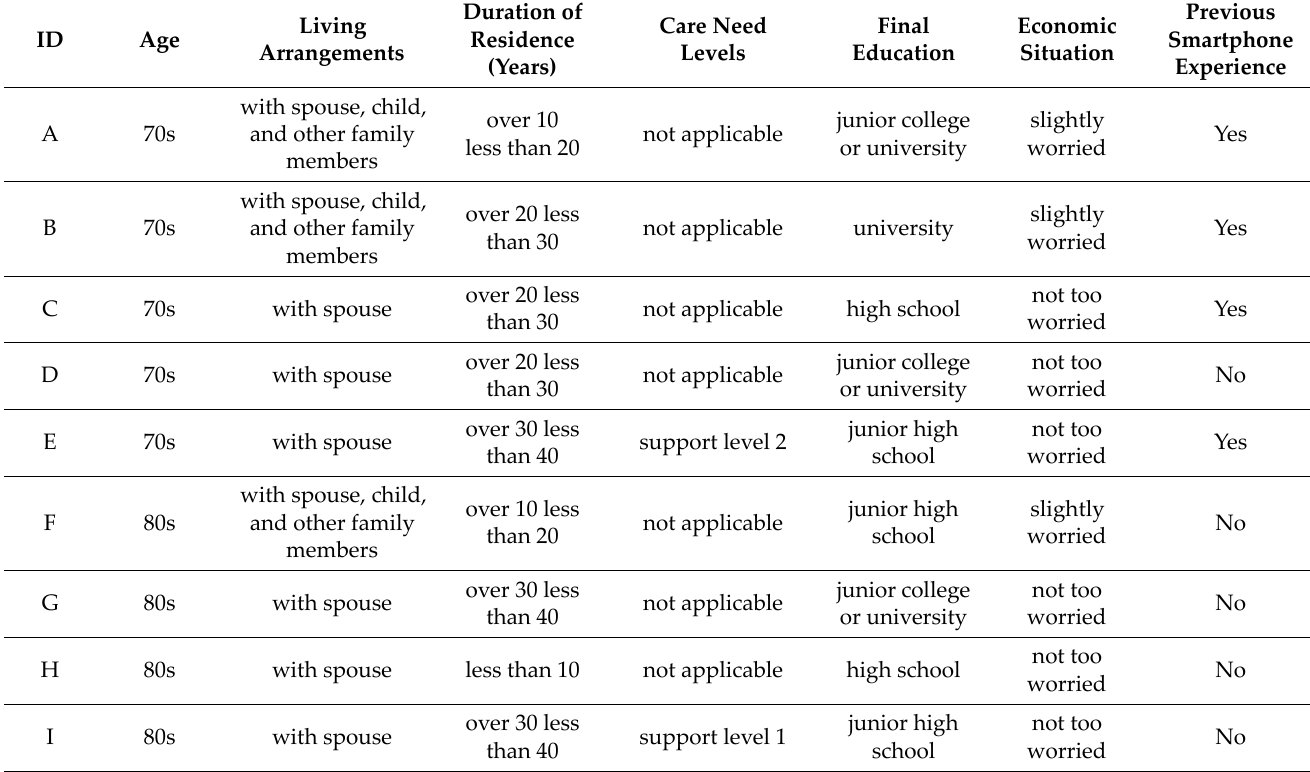
Table 1. Participants’